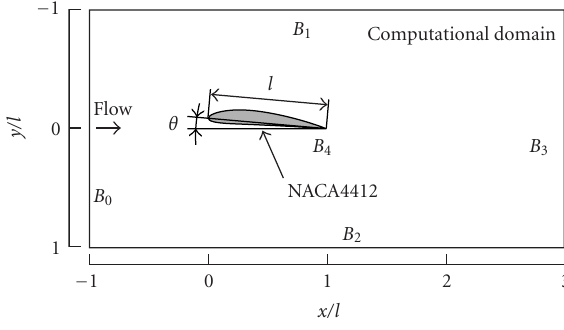
Figure 1: Quadrilateral element.